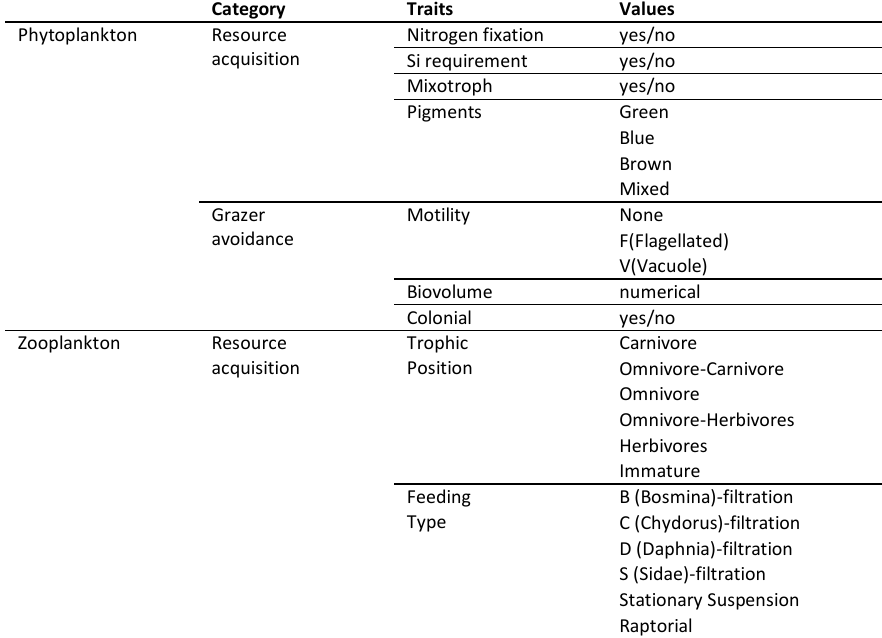
Table 2: Phytoplankton and zooplankton functional traits used in this